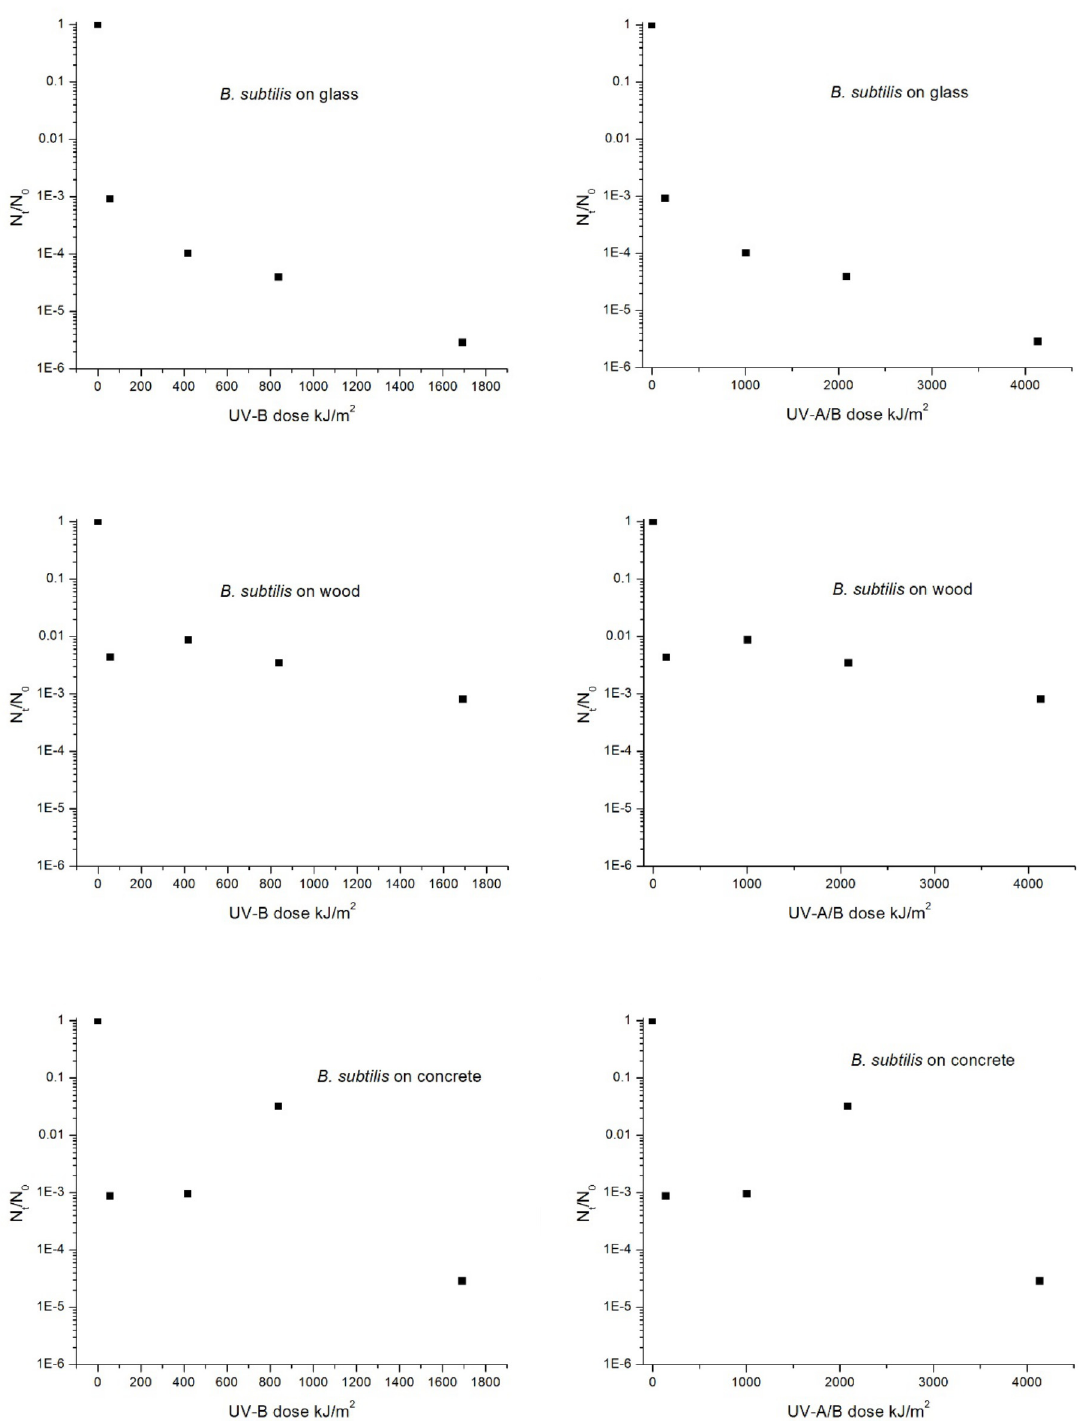
Fig 7. Decay of B . subtilis spores as a function of UV dose (kJ/m 2 ), species, and material. Dose values are shown for UV-B and UV-A/B and were determined based on measured UV intensities and exposure time.